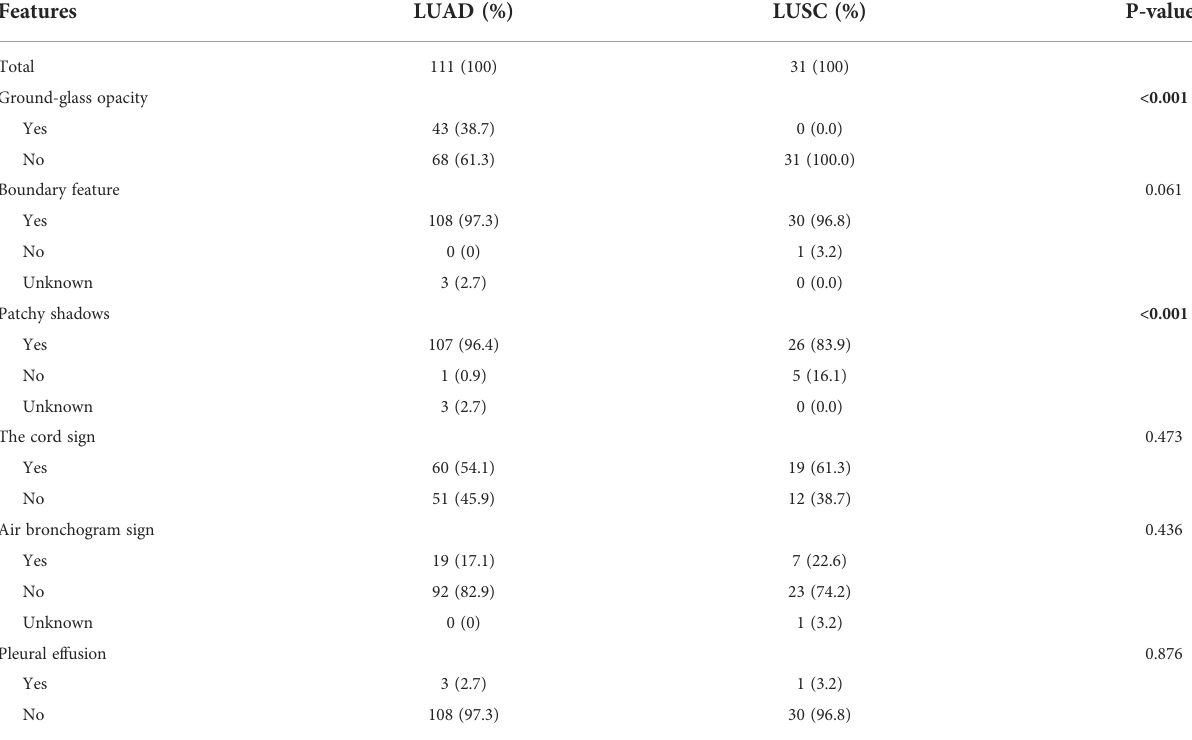
TABLE 3 Imaging data of the patients.